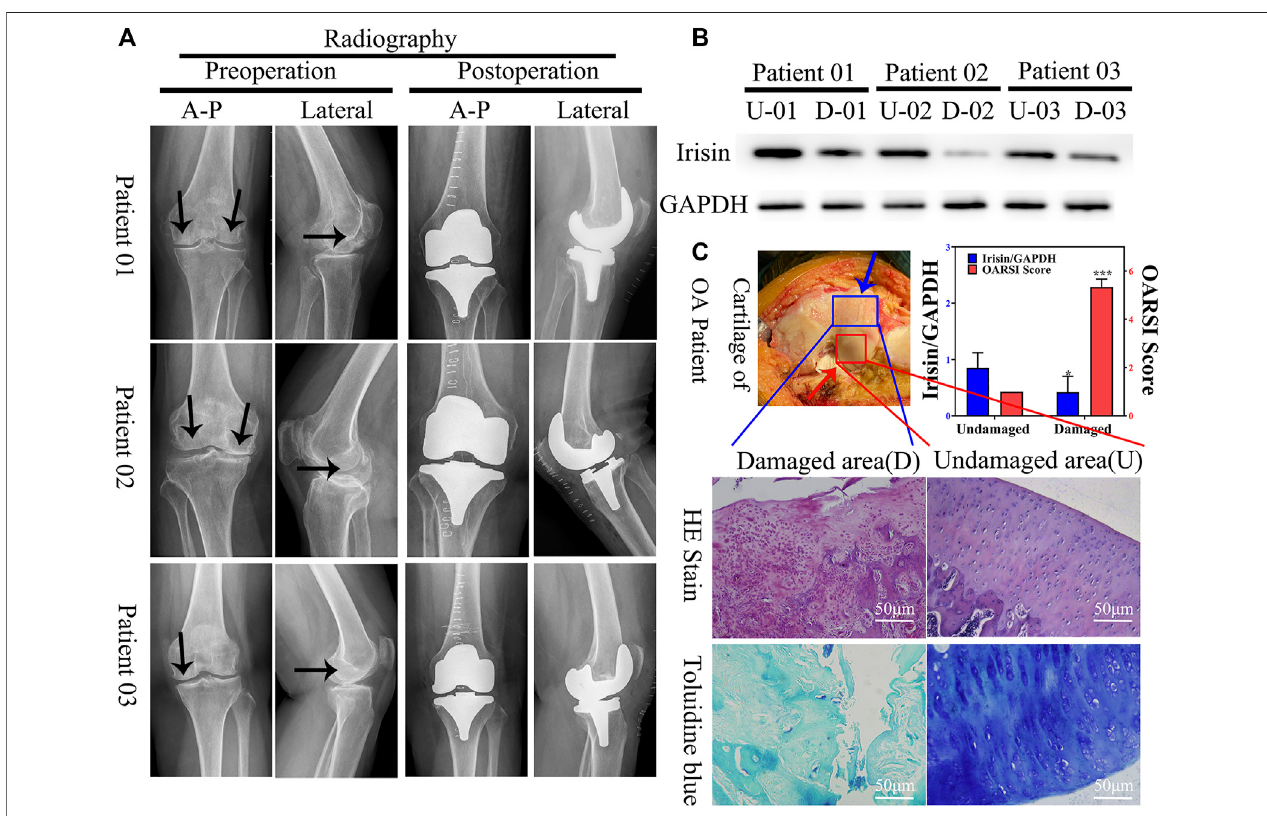
FIGURE 1 | Expression of irisin is downregulated in the damaged area of the articular cartilage in patients with knee osteoarthritis (OA). (A) Plain radiograph of patients with knee osteoarthritis (OA) ( n = 12). Black arrow indicate areas with more severe osteoarthritis. Anterior – posterior (A-P). (B) Relative protein level of irisin in undamaged (U) and damaged (D) areas, with GAPDH as control. (C) H&E and toluidine blue staining of knee articular cartilage. Blue arrow indicate damaged area, red arrow indicate undamaged area. Relative level of irisin and OARSI score. * p < 0.05; ** p < 0.01; *** p < 0.001.